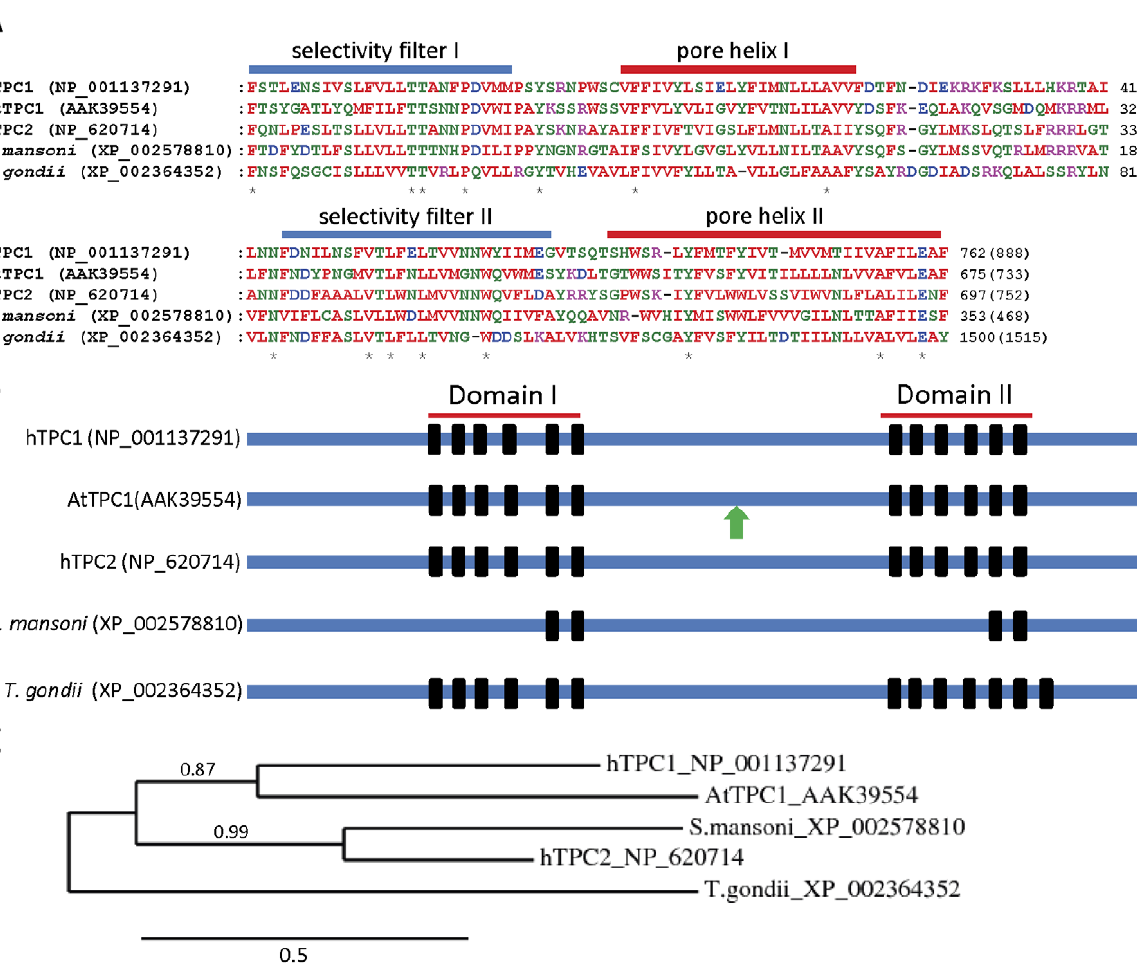
Figure 3. Comparison of human, plant and parasite TPC homologues. (A) Alignments of pore domains I (upper panel) and II (lower panel) of human, plant (AtTPC1 is Arabidopsis thaliana TPC1) and parasite TPC homologues. Asterisks below the alignment indicate absolute residue conservation in all homologues. (B) Schematic showing the location of transmembrane domains (black bars) within the full-length sequences of human, plant and parasite TPC homologues. The green arrow signifies an EF-hand repeat in AtTPC1. (C) Phylogram showing the relationship between full-length sequences of human, plant and parasite TPC homologues (see Methods: based on 220 high confidence positions from a multiple sequence alignment; gamma shape parameter 4.195; proportion of invariant sites 0.021) . Branch length scale bar and branch support values are